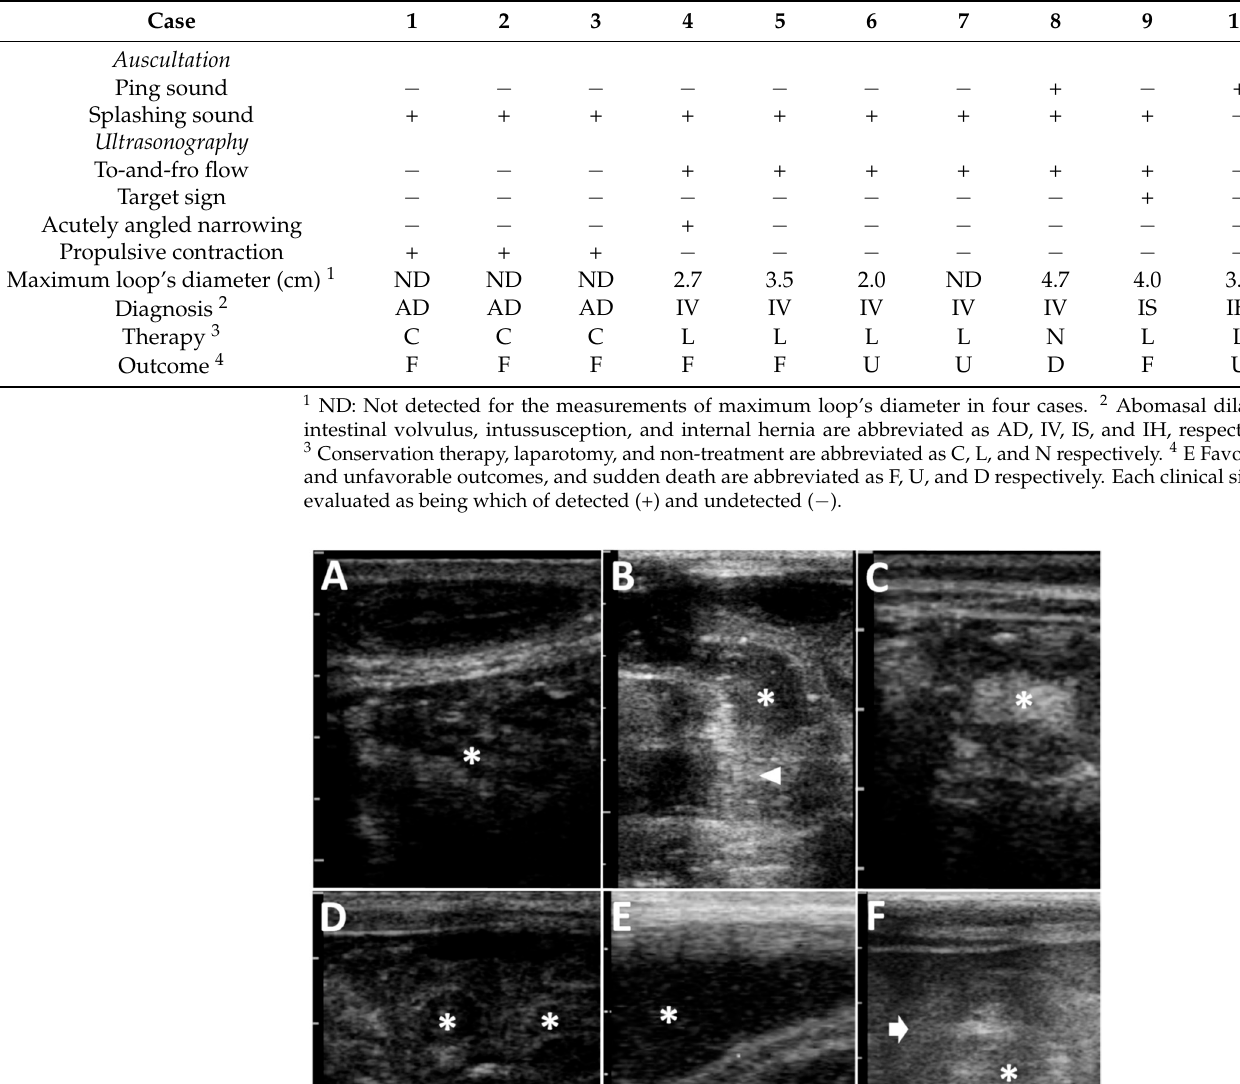
Table 2. Examination data, diagnosis, therapy, and outcome in ten present cases.